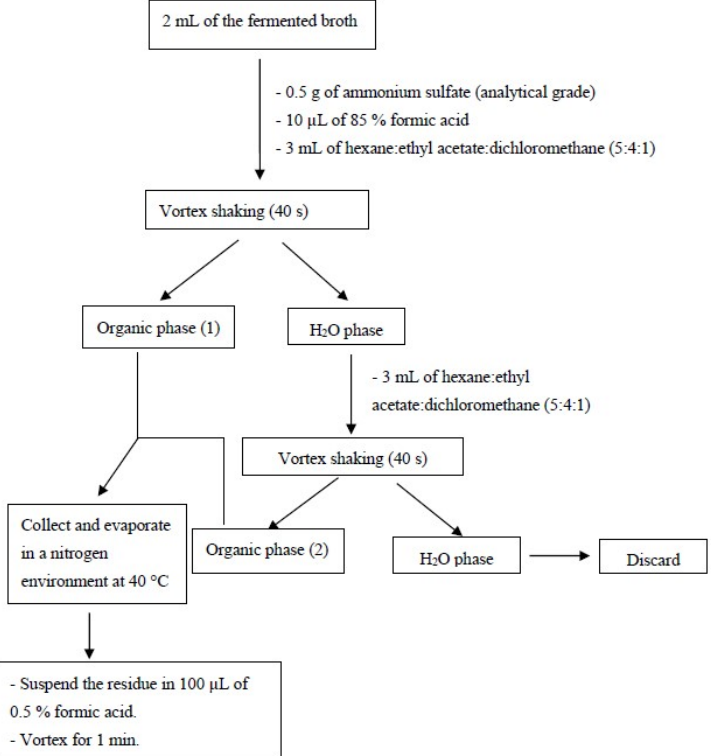
Figure 3. Flowchart of the liquid–liquid extraction for PTA, BHET, and MHET purification and pre-concentration from the fermented broth (adapted from Kim, Lee [44]).